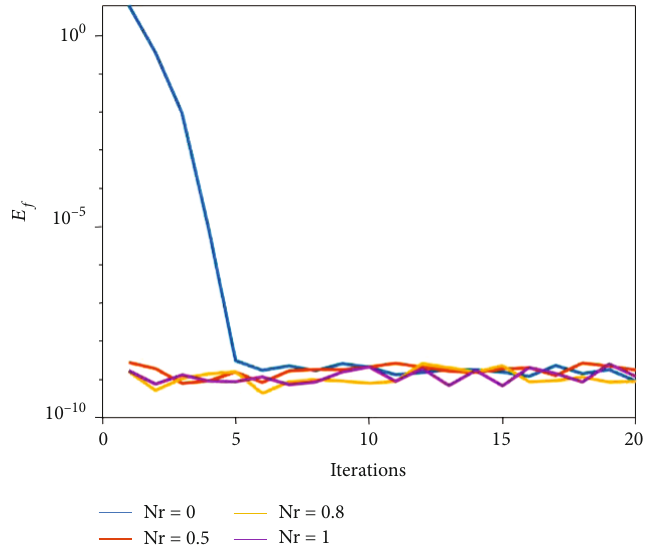
Figure 15: Concentration pro fi le for di ff erent values of Sc when λ = 0 : 1, N = 0 : 5, n = 0 : 5, f = δ = NR = 0 : 2, Sc = 0 : 6 , and Pr = 1